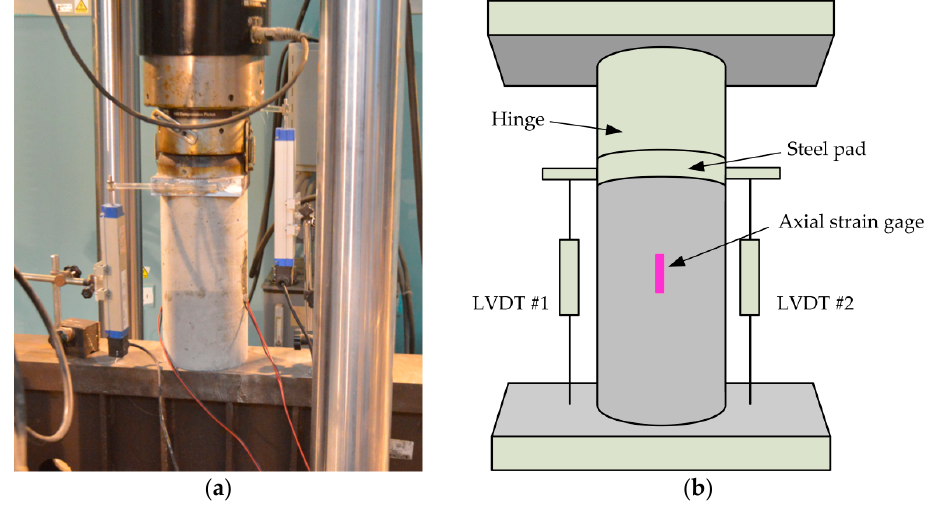
Figure 2. Test setup and instrumentation: ( a ) test setup; and ( b ) locations of strain gages and LVDTs.